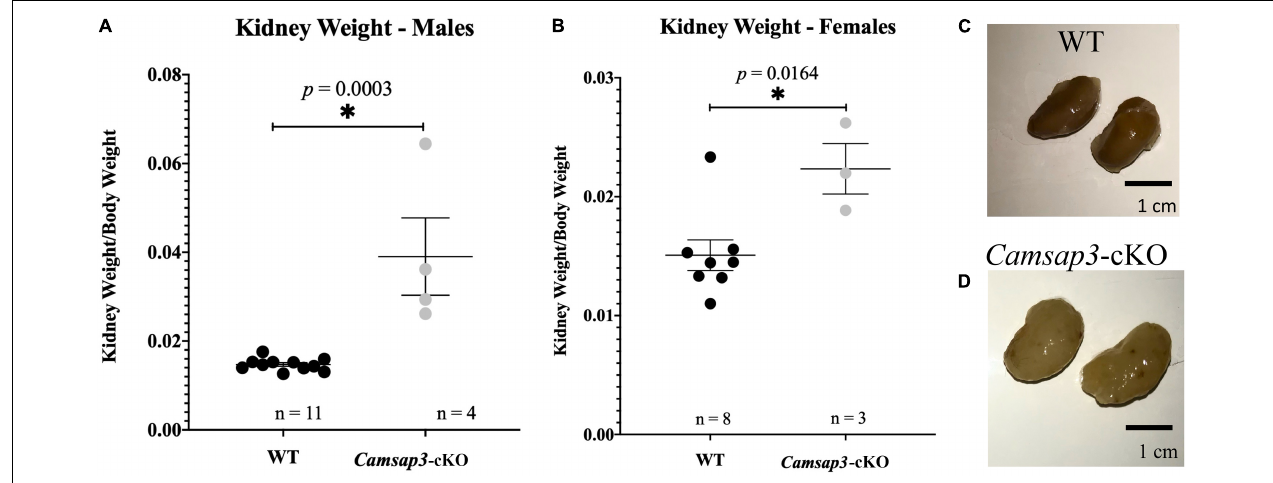
FIGURE 6 | Renal abnormalities in Camsap3 -cKO mice. (A,B) The kidney-to-body weight ratio in male (A) and female (B) . Unpaired t -tests revealed that Camsap3 -cKO mice (P22-P339) showed a statistically significant increase in their kidney-to-body weight ratio relative to their WT counterparts. p -values for each age group of mice were as indicated. Bars represent mean ± SD. (C,D) Representative kidney images taken from male, 1-year-old WT (C) and Camsap3 -cKO littermate (D) . Kidneys from the Camsap3 -cKO mouse were hypertrophic and discolored. *Statistically significant difference.